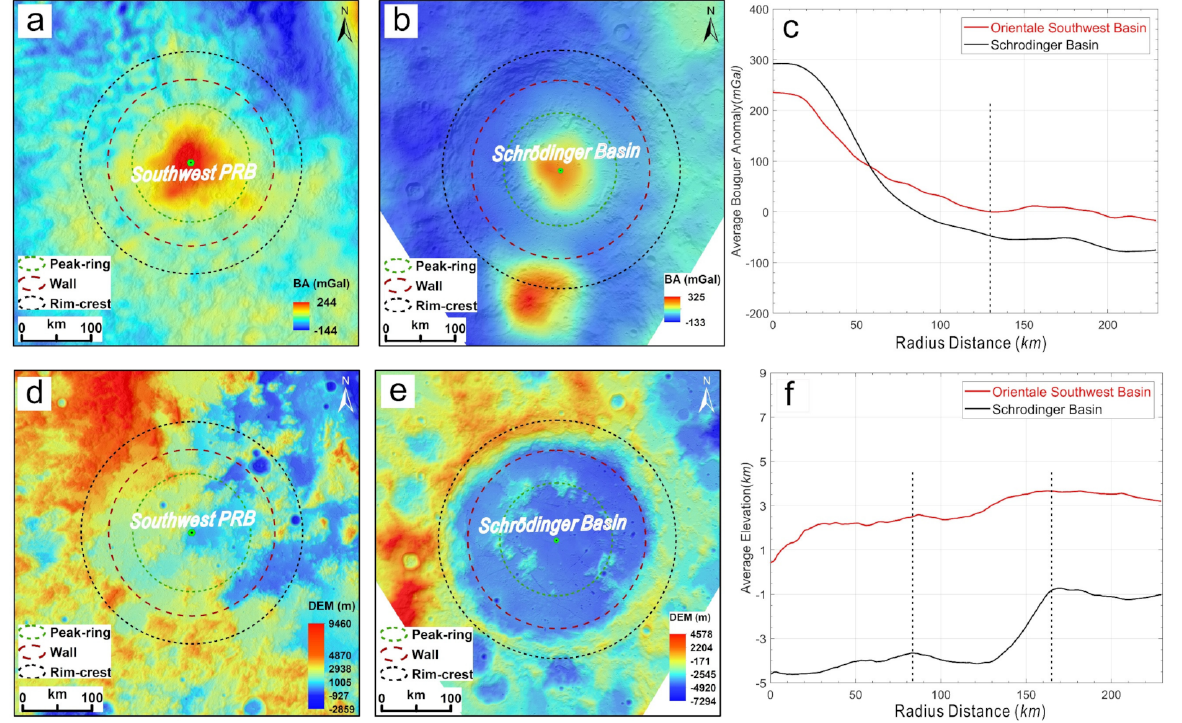
Figure 5. Comparison between pre-Orientale southwest peak–ring basin (left panel) and Schrödinger peak–ring basin (middle panel): Bouguer anomaly (up, a – c ), Topography (down, d – f ). ( a , d : Orthographic Projection centered at 108.8 ◦ W, 28.4 ◦ S; b , e : Orthographic Projection centered at 132.9 ◦ E, 74.7 ◦